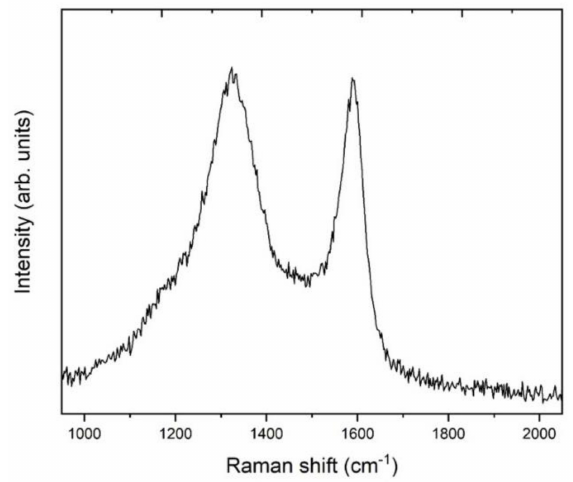
Figure 5. Registered micro-Raman spectrum for the obtained